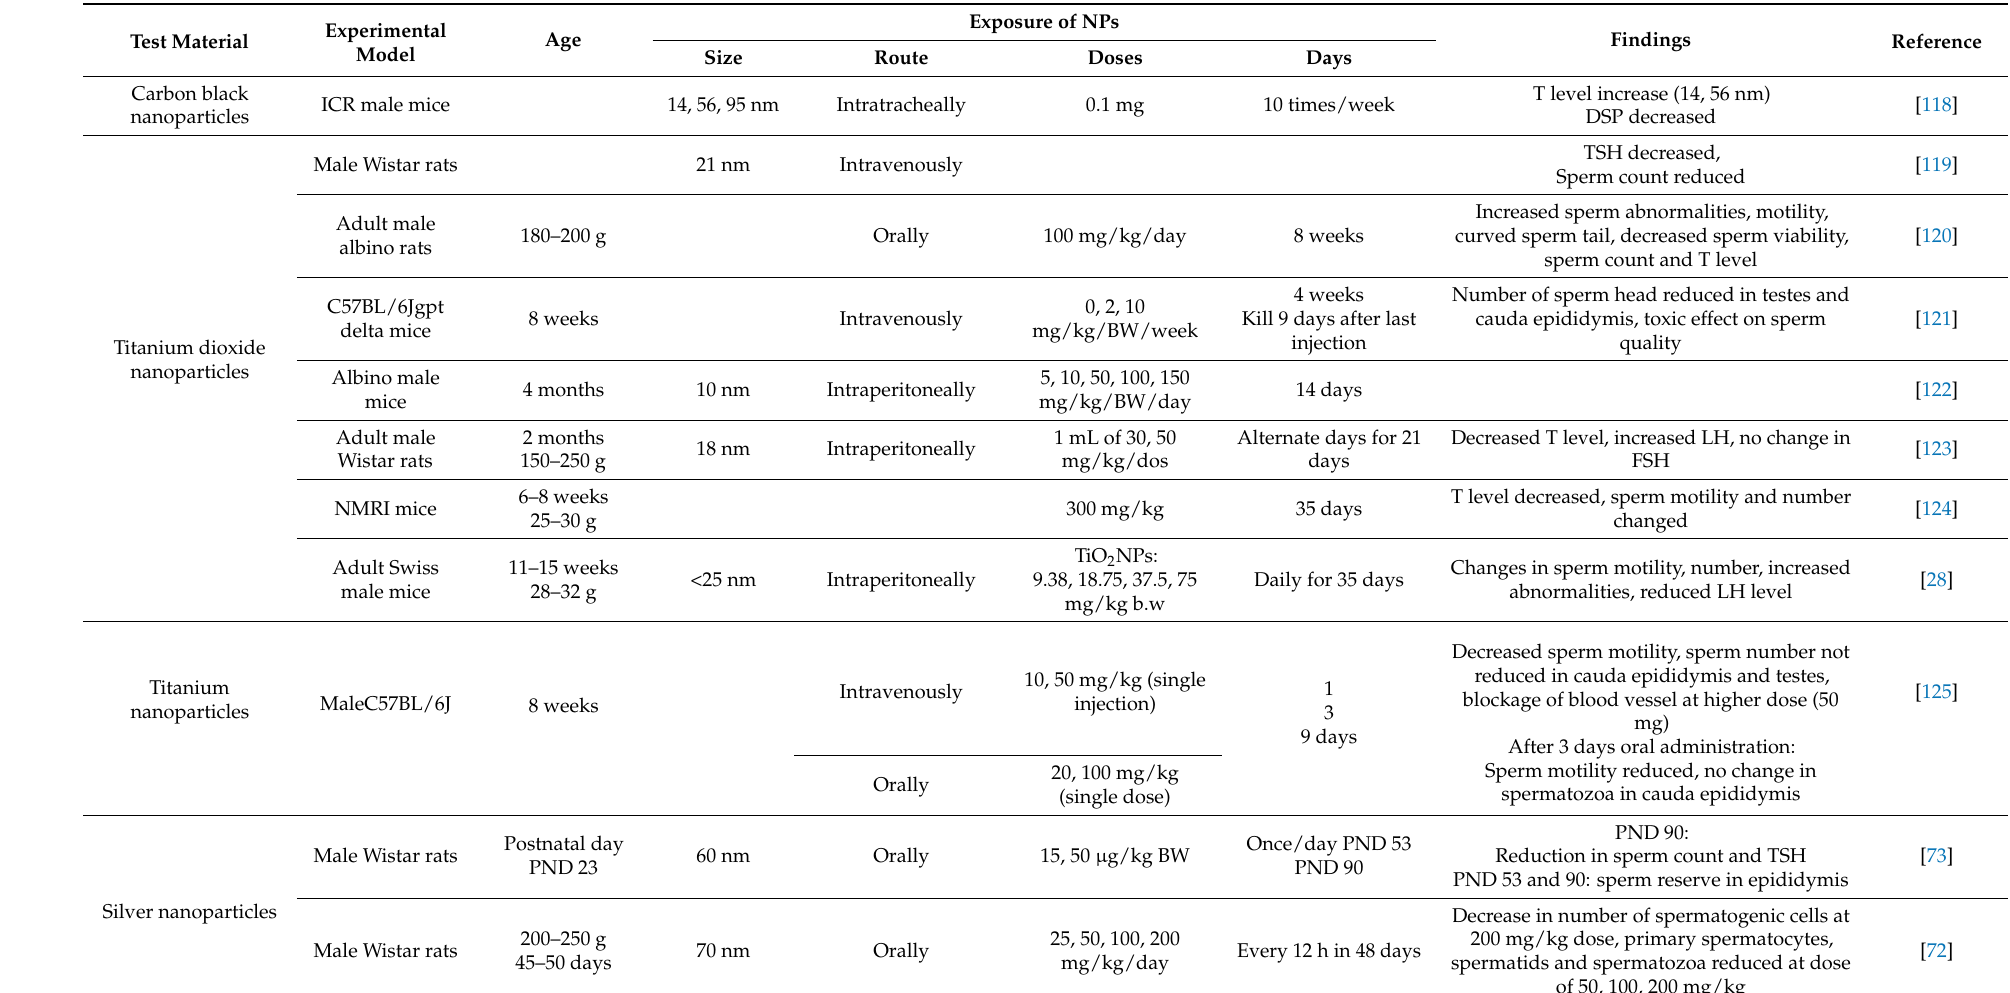
Table 3. Exposure to NPs and effect on